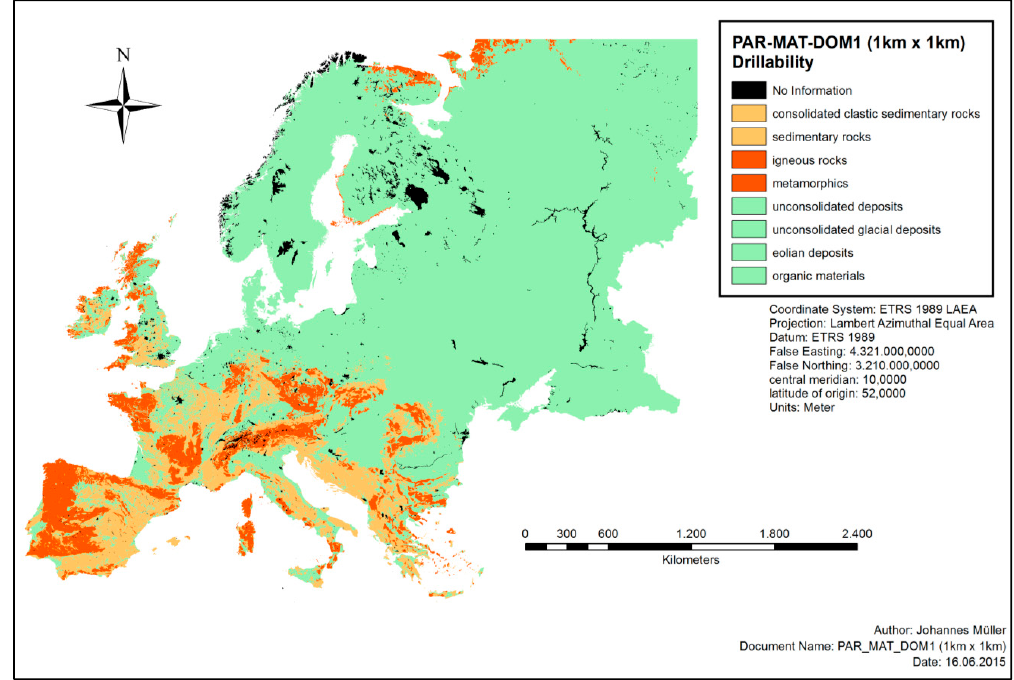
Figure 4. Drillability map using major groups for dominant parent material and using attributes of PAR-MAT-DOM1 (modified after [10–12]). Three classes of hardness: Green = slightly consolidated; orange = moderately consolidated; red = intensively consolidated.